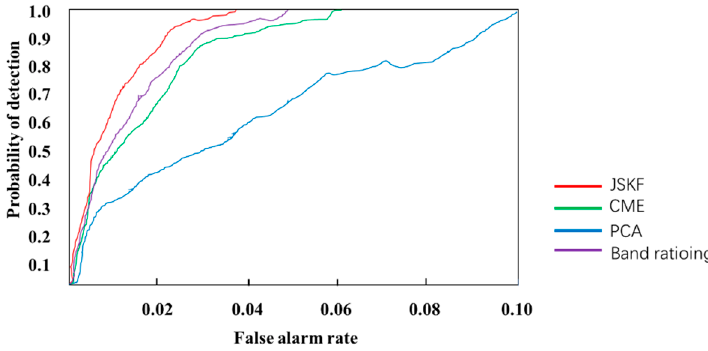
Figure 8. Comparison of ROC curves of anomaly detection results.